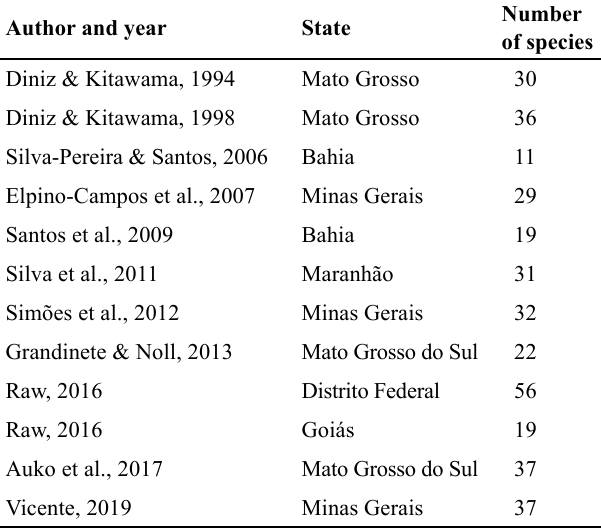
Table 1 . List of inventories of social wasps (Polistinae) in Cerrado areas, published by